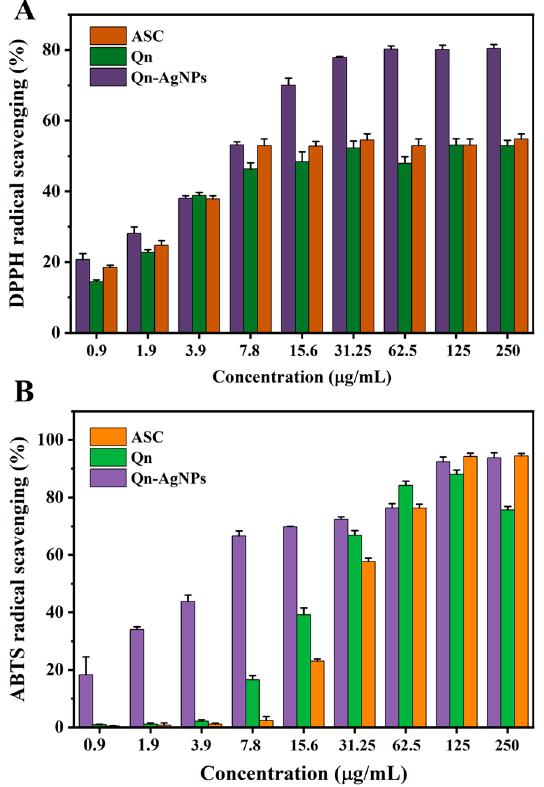
Figure 5. DPPH ( A ) and ABTS ( B ) radical scavenging activity of ascorbic acid (ASC), quercetin (Qn), and Qn-AgNPs.